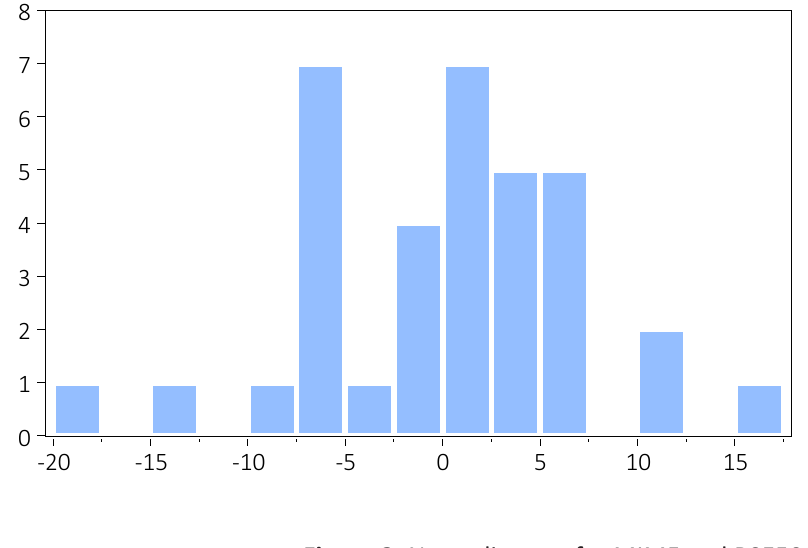
Figure 3. Normality test for MIMF and BSE500